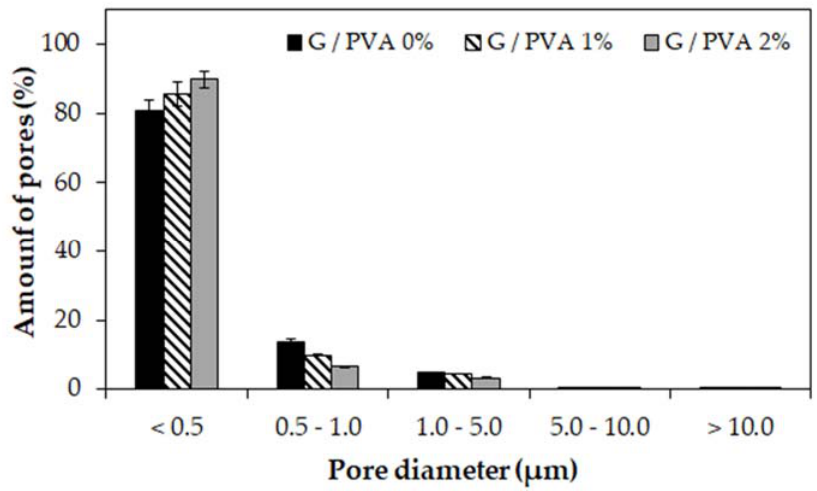
Figure 2. Histograms of the pore diameter distribution in hydrogel materials based on gelatin (G) and polyvinyl alcohol (PVA). Gelatin-based hydrogel without PVA (G/PVA 0%, black), a gelatin-based hydrogel with 1% w / v of PVA (G/PVA 1%, striped), and gelatin-based hydrogel with 2% w / v of PVA (G/PVA 2%, grey). In each case, the concentration of gelatin was 10% w / v .